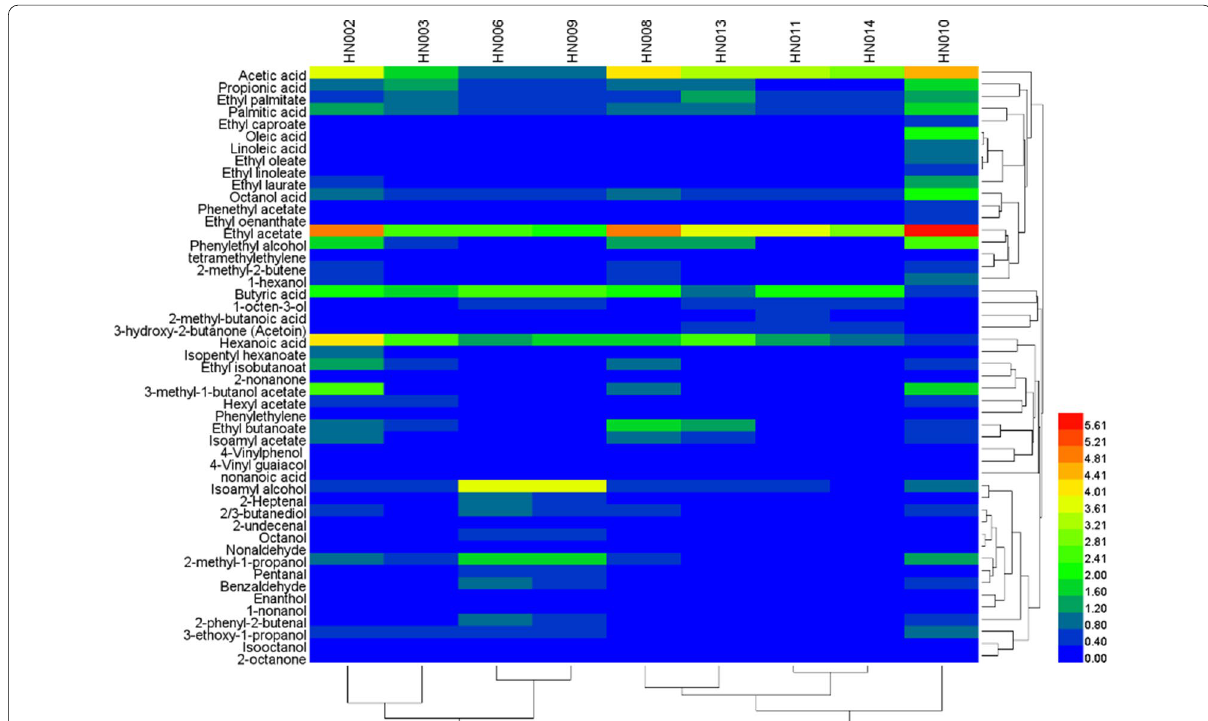
Fig. 2 Heatmap illustrating the differences in the concentrations of volatile compounds in the samples of Chinese chestnut wine prepared with various yeast